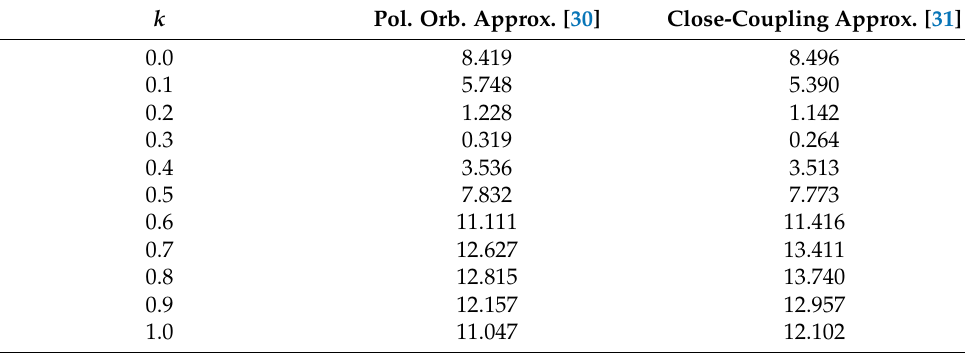
Table 11. Photoionization cross sections (10 − 20 cm 2 ) of Na